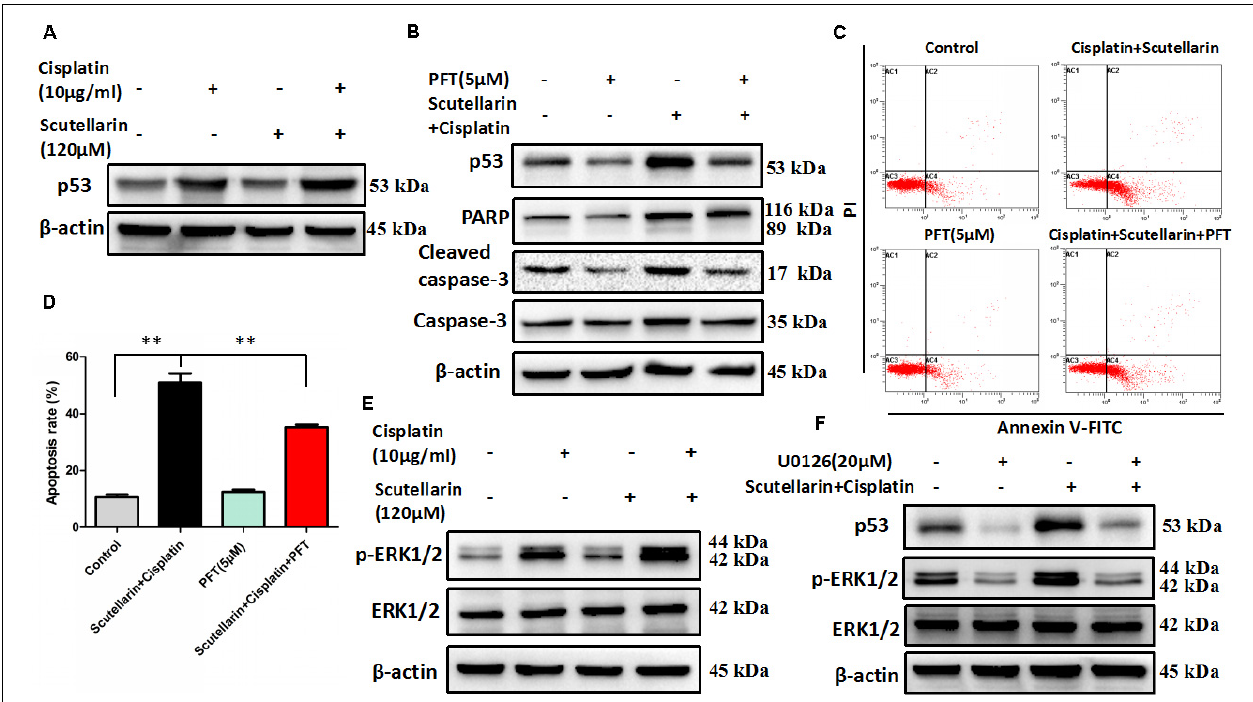
FIGURE 3 | Scutellarin enhanced cisplatin-induced apoptosis through the ERK1/2-mediated p53 signaling pathways. (A) Western blot analysis of p53 protein in A549/DDP cells treated by cisplatin, or scutellarin, or the combination. (B) The effect of p53 inhibitor PFT on p53, caspase-3, cleaved caspase-3 and PARP expression levels was measured by western blot analysis. (C,D) Flow cytometric analysis showing apoptosis in cells treated by cisplatin plus scutellarin, or PFT, or the combination. (E) The expression of p-ERK1/2, ERK1/2 were determined by western blot analysis. (F) The level of p-ERK1/2, ERK1/2, p53 in A549/DDP cells were measured in the presence of ERK1/2 specific inhibitor U0126. Data are representative of three independent experiments (mean ± SEM). ∗∗ p < 0.01.